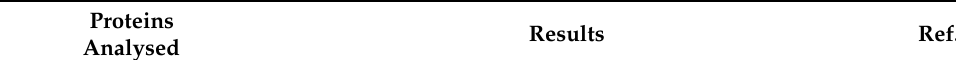
Table 1. NRF2 expression and correlation with ovarian cancer